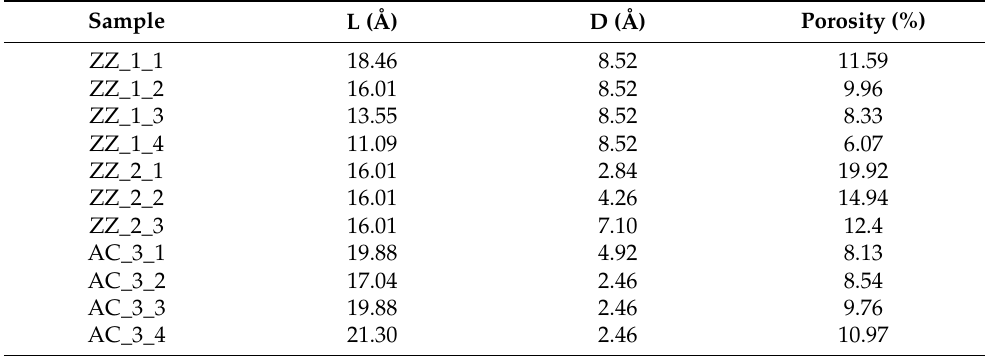
Figure 1. ( a ) Generation of a single-atom incised GK membrane. The carbon atoms in the dotted rectangle were excavated and all dangling bonds were capped using hydrogen atoms. Hydrogenated GK membranes incised in ( b ) zigzag and ( c ) armchair direction. Table 1. Design parameters of the single-atom incised GK membranes.